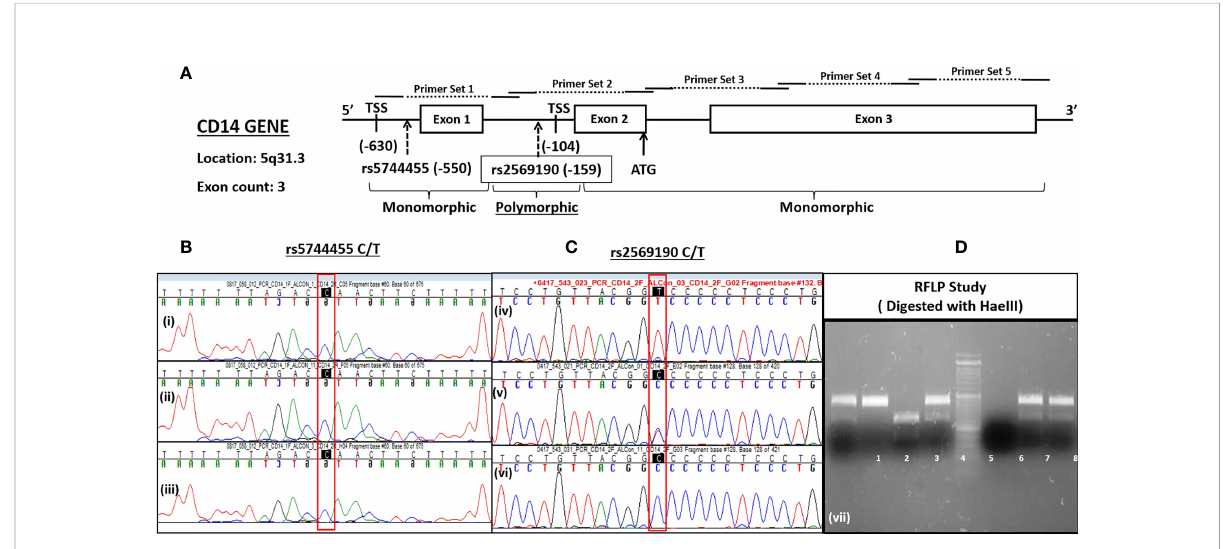
FIGURE 2 Schematics of CD14 gene (A) and its SNP genotyping by sequencing (B, C) and RFLP (D)